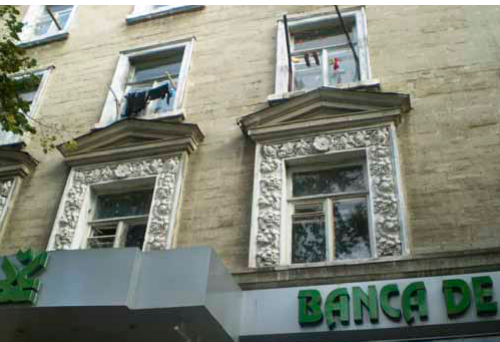
fig. 21. The motive of grapes in socialist realism archi- tecture of Chisinau. r. Čepaitienė photo